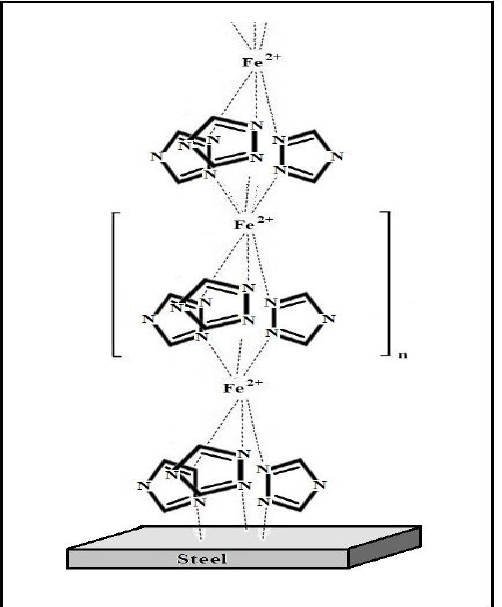
Figure 11. Schematic of the structure of the polymer-like iron-azole surface layer.